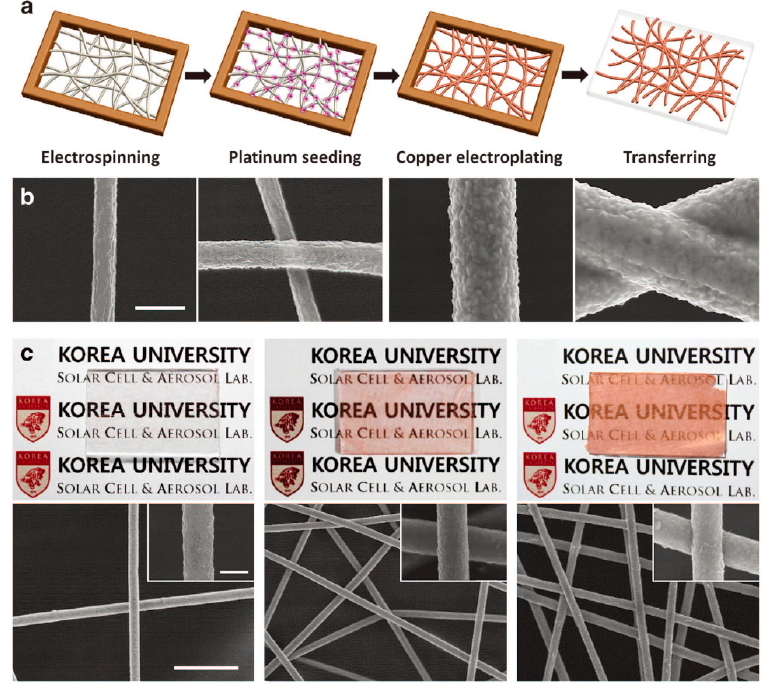
Figure 9. ( a ) Schematic representation of the CFH fabrication process. ( b ) SEM images of pristine PAN, platinum-seeded, Cu-electroplated, and transferred nanofibers. The scale bar is 1 µ m, and ( c ) photographs and corresponding SEM images of the CFHs on glass substrates with first electrospinning times of 5, 90, and 180 s. The scale bars are 10 µ m; those for the insets are 1 µ m. Reproduced from Ref. [109].